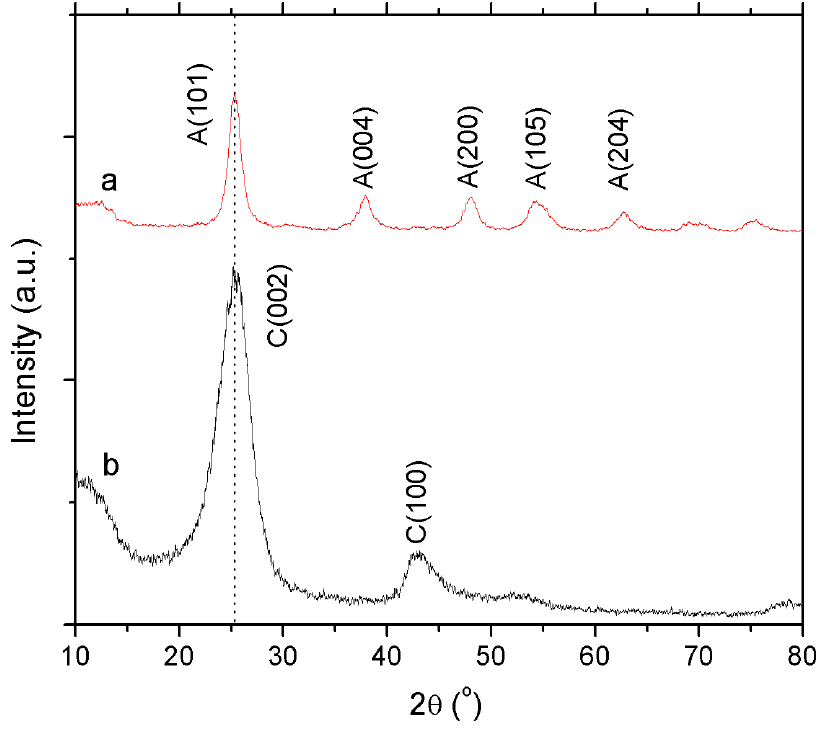
Figure 3. XRD di ff ractograms of (a) TiO 2 –fCNT and (b) Figure 3. XRD diffractograms of (a) TiO 2 –fCNT and (b) fCNTs.